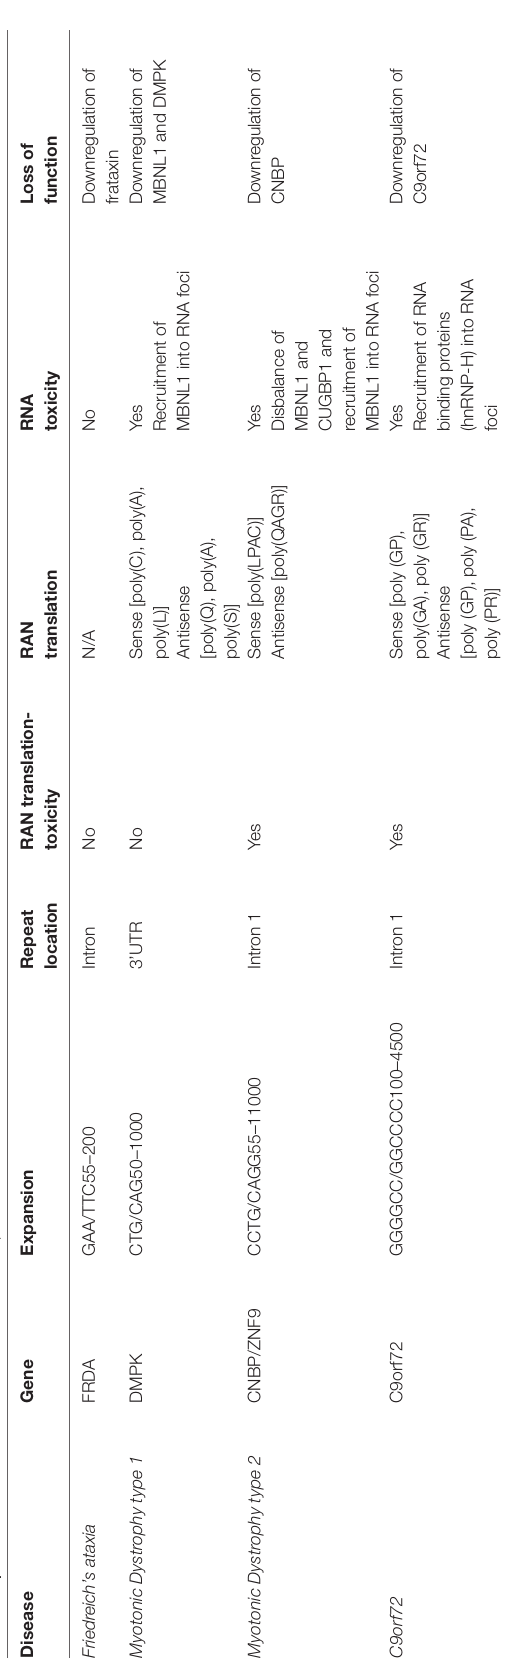
alternative splicing (Miller et al., 2000). The sequestration of MBNL in RNA foci leads to upregulation of CUG-binding protein (CUGBP1; Lin et al., 2006). This imbalance of MBNL and CUGBP1 causes splicing defects on several mRNAs (Philips et al., 1998). DM1 seems to produce RAN translation products, including poly (C), poly (A), and poly (L) from the sense strand, and poly (Q), poly (A), and poly (S) from the antisense strand. However, it is unclear whether these DPR products are pathogenic (Zu et al., 2017). Downregulation of DMPK leads to mild myopathy in knockout mice, suggesting it plays a minor role in the disease (Jansen et al., 1996). DM2 is less frequent than DM1 and the clinical presentation varies (Meola and Cardani, 2015). DM2 is caused by an expansion of CCTG repeats in the intron of cellular nucleic acid binding protein (CNBP), also known as Zinc finger factor 9 (ZNF9). The disease mechanism of DM2 is similar to DM1 and is caused by RNA toxicity with the formation of RNA foci with recruitment of MBNL1 protein and disbalance between MBNL1 and CUGBP1 (Jones et al., 2011). Furthermore, RAN translation produces the peptides poly (LPAC; sense) and poly (QAGR; antisense). Contrary to DM1, DM2 RAN translated peptides are present in autopsy tissues from patients with DM2 and seem to be toxic in cells independent of RNA gain of function (Zu et al., 2017). Haploinsufficiency of CNBP